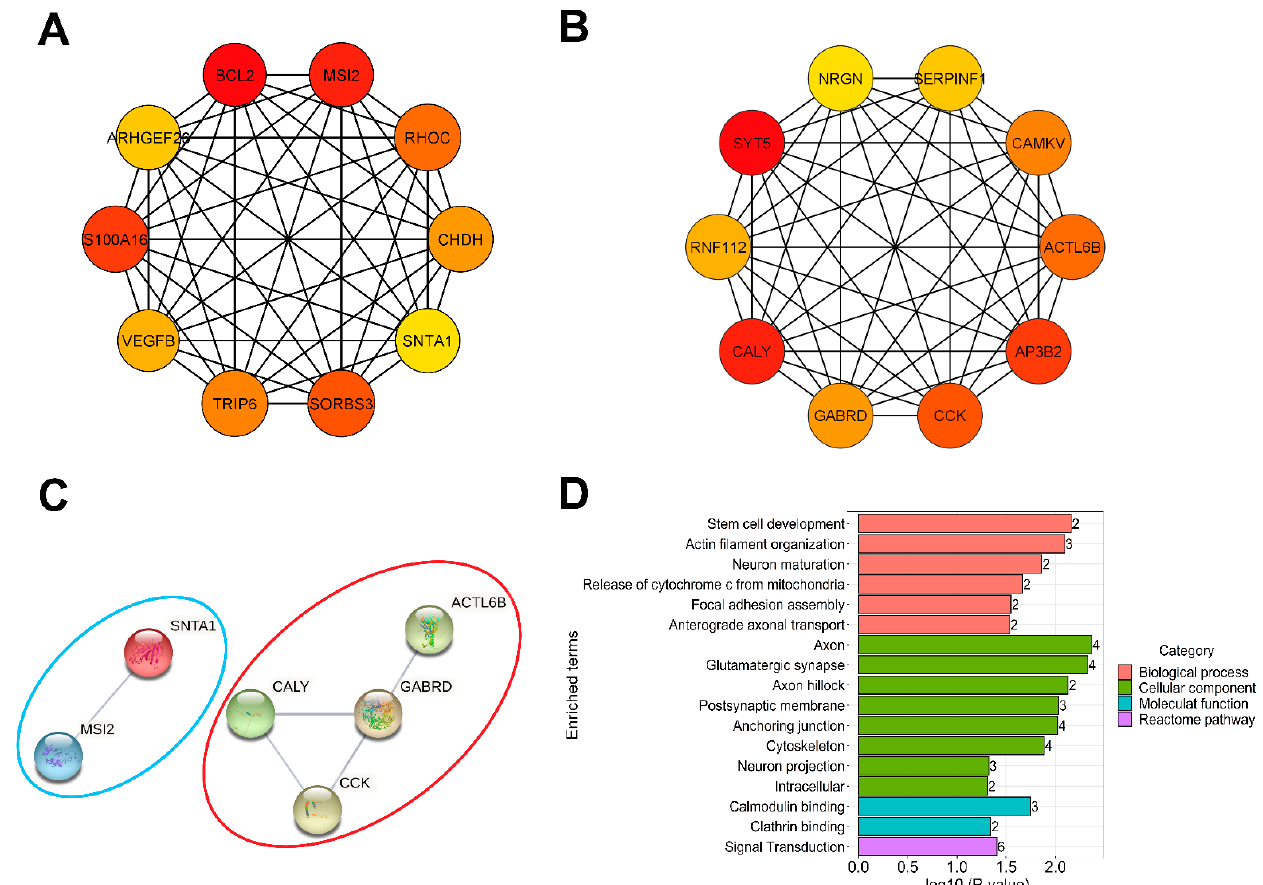
Figure 6. Hub gene analysis of co-expression networks. ( A , B ) The top 10 hub genes from down- and upregulated co-expression networks were screened according to the MCC score using the CytoHubba plugin of Cytoscape. ( A ) shows the top 10 hub genes of downregulated co-expression network and ( B ) represents the top 10 hub genes of upregulated co-expression network. The change in color from red to yellow represents a change in degree score from high to low. ( C ) PPI network of hub genes constructed using STRING Online Database. The network contains 20 nodes and 5 edges compared to the expected number of edges (1). The PPI enrichment p -value was 0.00815. The blue circle represents the interaction network of downregulated hub gens, while the red circle indicates the interaction for upregulated hub genes. ( D ) GO and Reactome pathway classification of the top 10 down- and upregulated hub genes. Bar plots describing the significantly enriched terms related to down- and upregulated hub genes with the p -value < 0.05. The table describes, for each term, the number of mapped annotated genes in the reference data set and its − log10 p -value. The color code is proportional to the